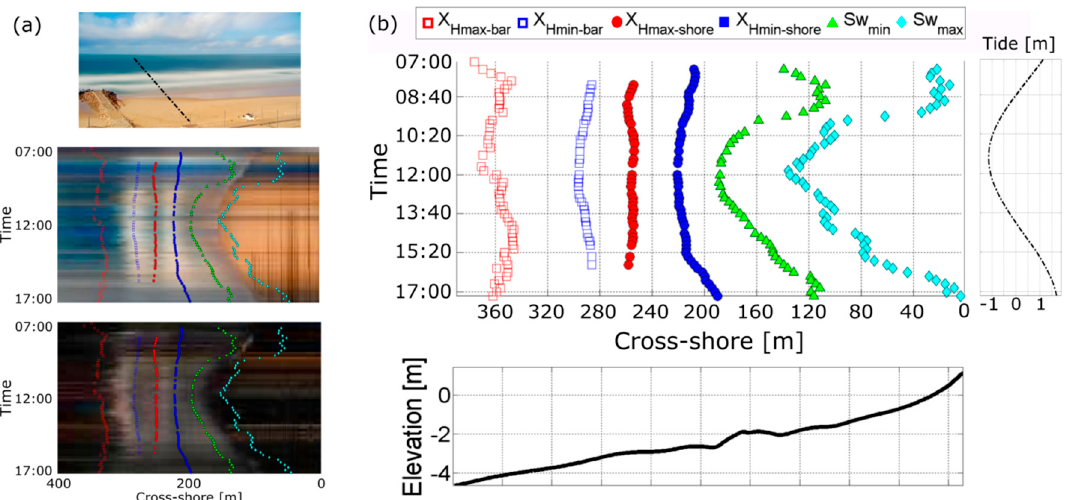
Figure 9. Spatial and temporal variation of wave transformation domains at Tarquinio-Paraiso. ( a ) Wave transformations domains boundaries plotted on TimexStack (middle) and on VarStack (lower) images generated sampling the pixel transect (upper) over Timex and Variance dataset; ( b ) wave transformations domains boundaries plotted over space and time in relation to water level and beach profile. Note that beach profile does not correspond to survey during video data acquisition and it is shown for a rough reference of bottom elevation.